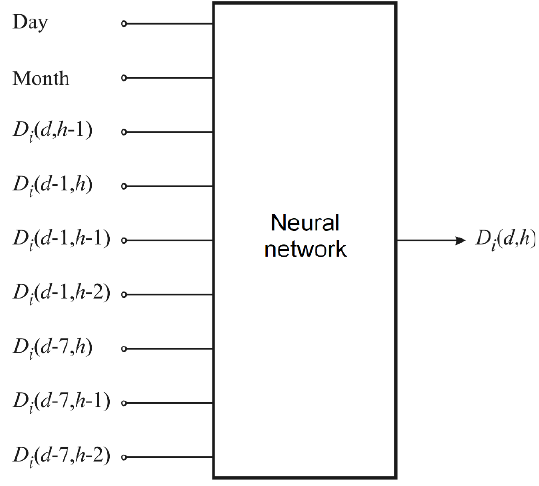
Figure 7. The neural system is used for the prediction of wavelet coefficients D i ( d,h ). An identical structure is applied for the prediction of the coarse approximation signal A N ( d , h ) on the final N th level of the wavelet decomposition.